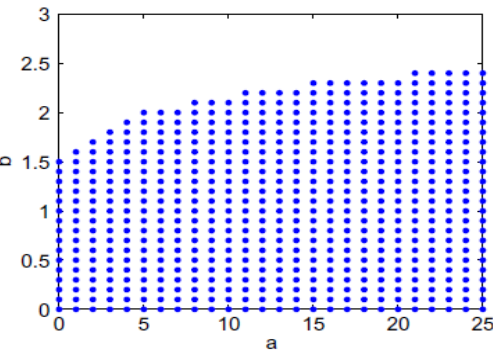
Figure 2. Stability regions using Theorem 6 in Reference [28].